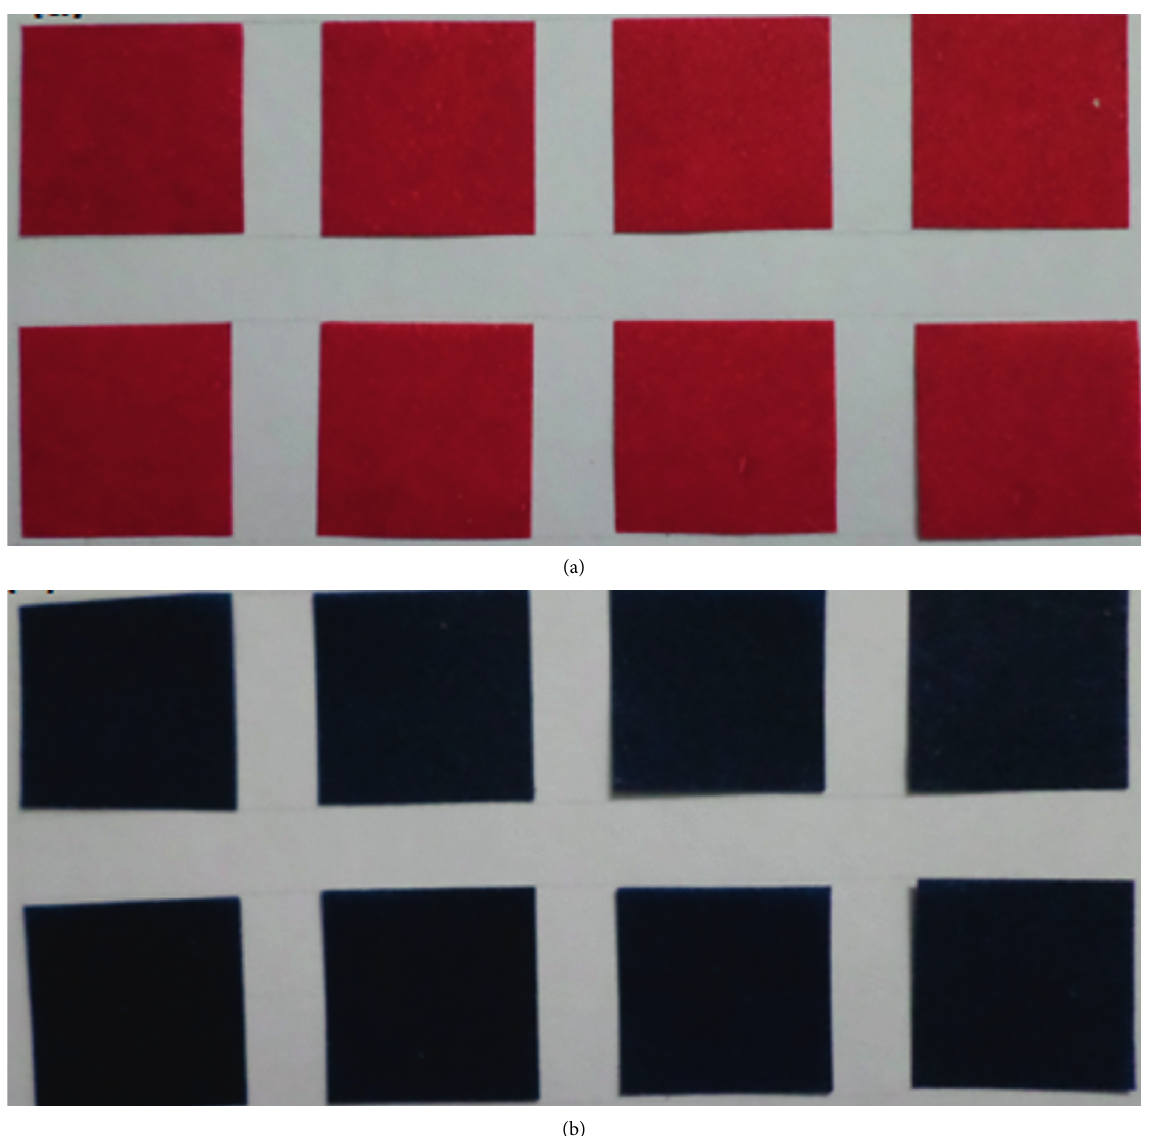
Figure 2: The samples printed with red printing ink (a) and with blue printing ink